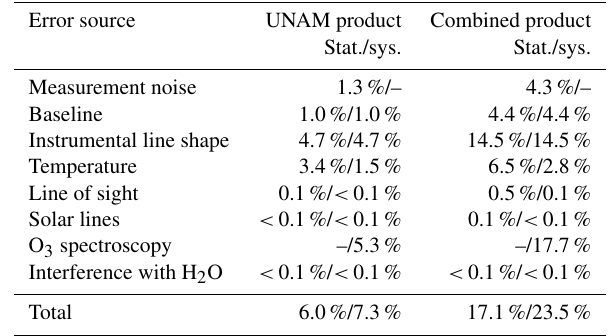
Table 3. Estimated errors for the boundary layer O 3 remote sens- ing (retrieval results for 2.3km altitude). Listed are statistical and systematic errors of the UNAM product and the combined